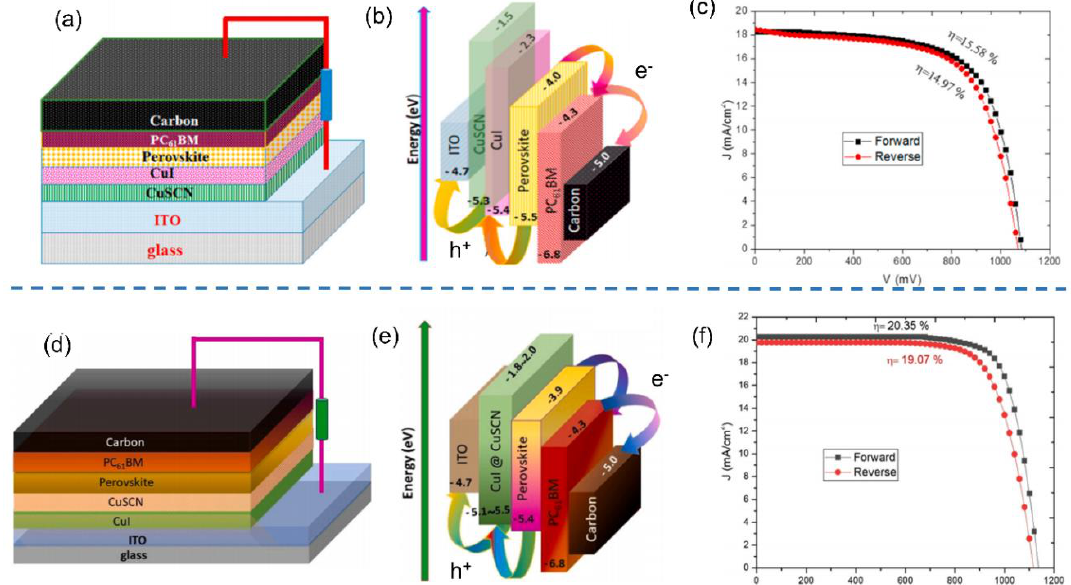
Figure 14. ( a ) Structural diagram and ( b ) energy levels and ( c ) J–V curves under reverse and forward scan directions of carbon-based inverted PSCs with bilayer CuSCN/CuI HTL. Reproduced from [139], with permission from the Journal of Alloys and Compounds, 2021. ( d ) Structural diagram and ( e ) energy levels and ( f ) J–V curves under reverse and forward scan directions of carbon-based inverted PSCs with bilayer CuI/CuSCN HTL. Reproduced from [140], with permission from the Ceramics International, 2021.